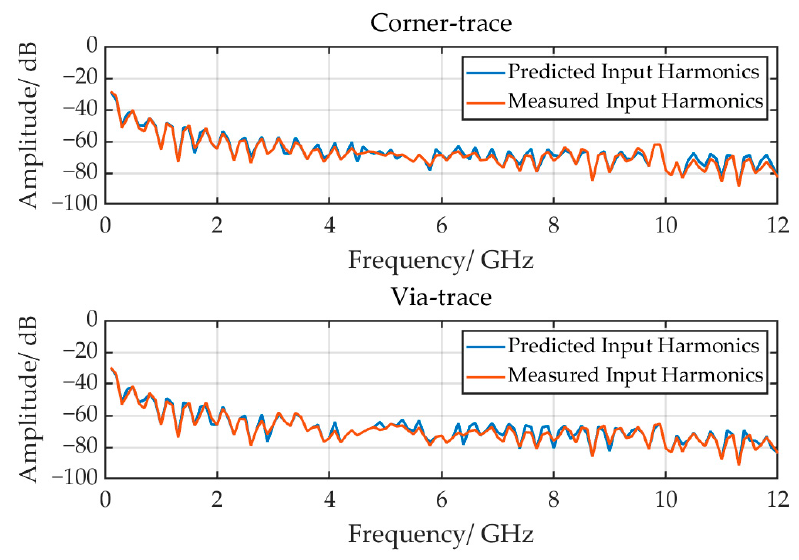
Figure 10. Amplitude of predicted and corrected harmonics of the input signal.